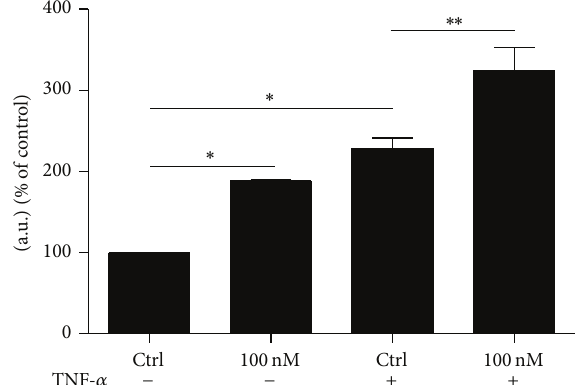
Figure 7: NF 𝜅 B activation during DC activation. After the differ- entiation period (5 days), cells were incubated for 10min with or without TNF- 𝛼 (50ng/mL), in the presence or absence of 100nM Oua. Then, the phosphorylation of NF 𝜅 B was evaluated by Western blot. Signals are expressed in arbitrary units (% of control) as the mean ± SEM of 3 independent experiments ( ∗ 𝑃 < 0.05 ; ∗∗ 𝑃 < 0.01